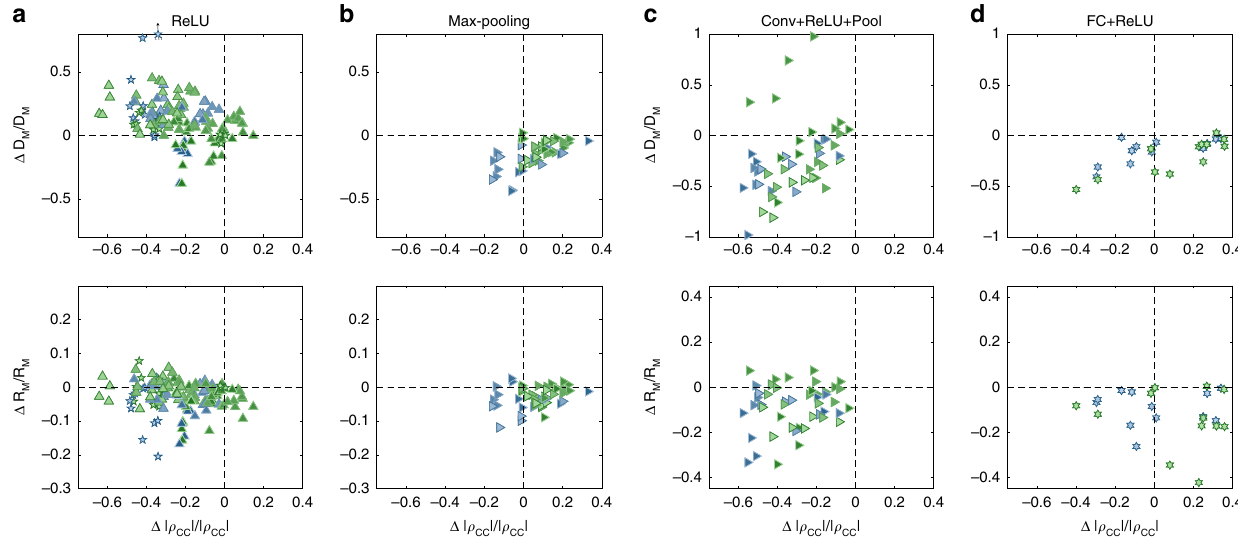
Fig. 8 Manifold property changes by network building blocks. Changes in the relative manifold properties between the input and the output of different network building blocks, shown as change in dimension vs change in center correlations (top) and change in radius vs change in center correlations (bottom). Each panel pools results from a speci fi c building block in AlexNet (blue markers) and VGG-16 (green markers) for both point-cloud manifolds (full class, top 10%) and smooth manifolds (1-d and 2-d, translation and shear). Marker shape represents layer type (square — convolution layer, right- triangle — max-pooling layer, hexagon — fully connected layer). For layer sequences marker shape represents the last layer in the sequence. For isolated ReLU marker shape represent previous layer type; pentagon — ReLU after fully connected layer, up-triangle — ReLU after convolution layer. Color changes from dark to light along the network. a Changes in manifold properties for isolated ReLU operations. b Changes in manifold properties for isolated Max- pooling operations. c Changes in manifold properties for a common sequence of operations: one or more repetitions of convolution, ReLU operations, with or without intermediate normalization operation, ending with a max-pooling operation. d Changes in manifold properties for a common sequence of operations: fully connected, ReLU operations. The data analyzed here correspond to the fi rst set of objects used in the analysis of the mean and con fi dence interval presented in Figs. 6 and 7, and include additional intermediate values not presented in those plots, notably the inputs of ReLU operations.